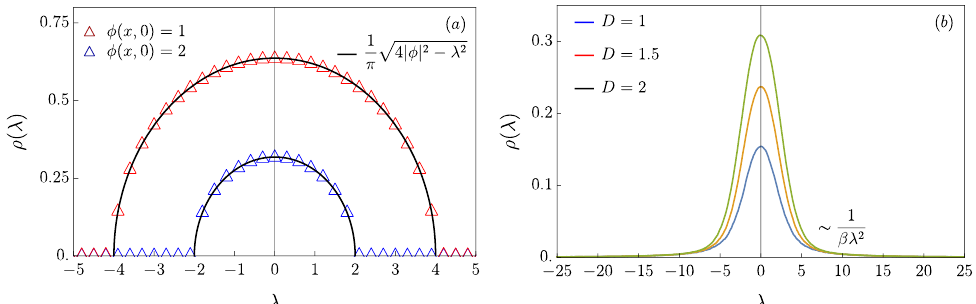
Figure 9: (a) Classical root densities for homogeneous initial field configurations. Continuous black lines are theoretical predictions Eq. (113) while the triangles are numerical samples. (b) Root densities for different values of the density of particles D = | φ ( x ) | 2 computed with the procedure described in this Appendix and averaged over 10 4 realizations. The field configurations are sampled from a free thermal en- ´ L φ | 2 − µ | φ | 2 ) and inverse temperature β = 0.4. semble with Hamiltonian d x ( | ∂ x 0 The value of the chemical potential µ is adjusted in order to obtain the desired value of the density. For large values of the rapidity, the effect of the interaction is negligible and the root density decays as ρ ( λ ) ∼ 1 / ( βλ 2 )